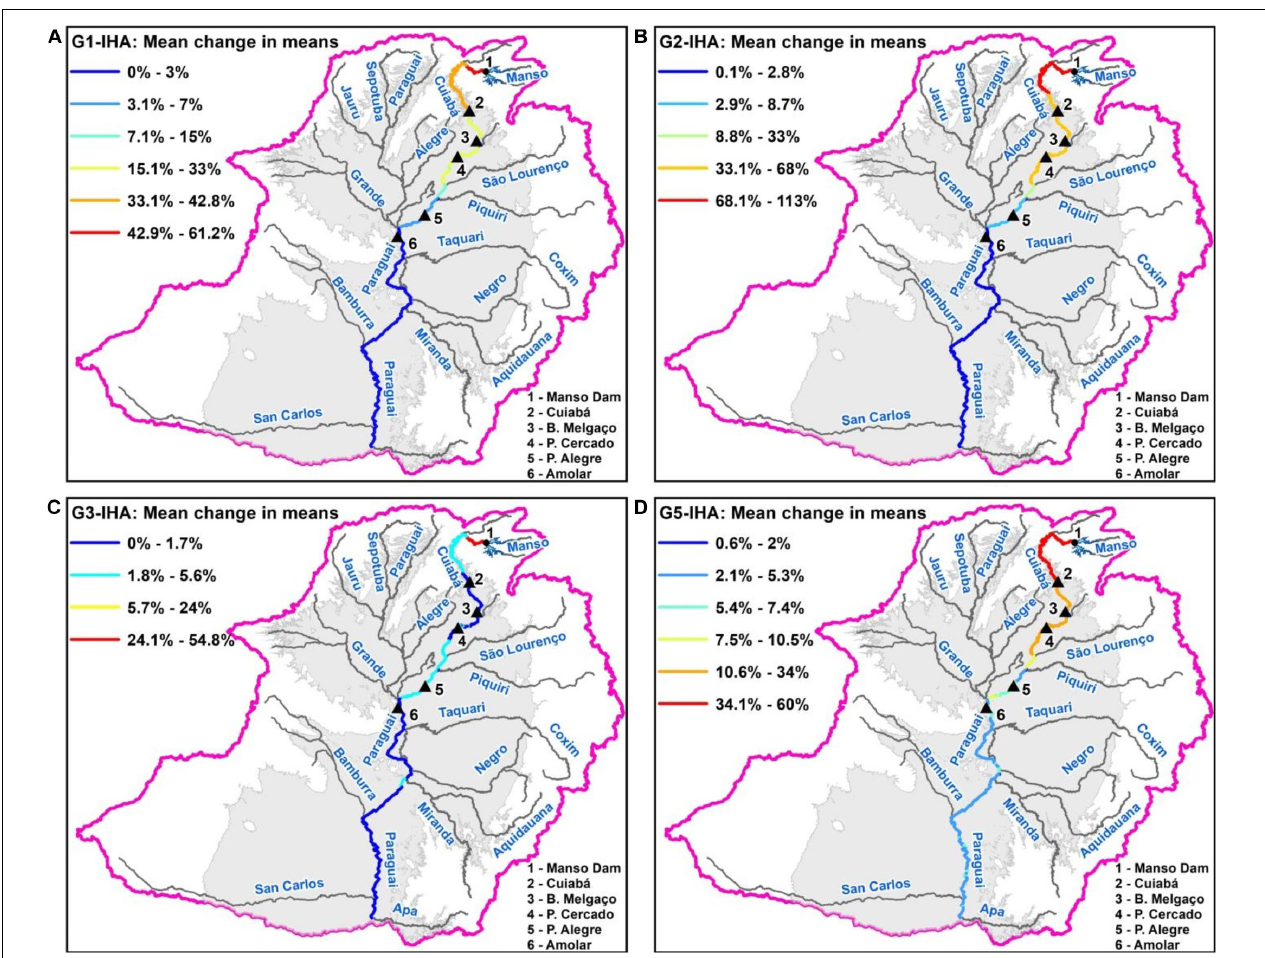
FIGURE 4 | Mean changes in means from Groups 1 (A) , 2 (B) , 3 (C) , and 5 (D ) of IHA statistics due to Manso operation.